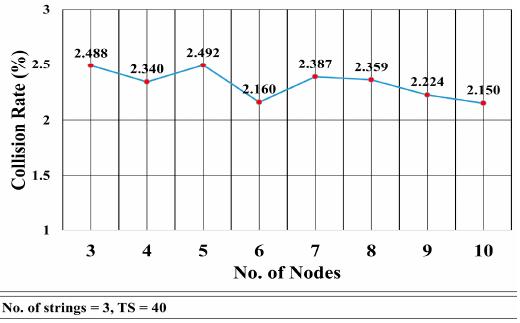
Figure 17. Collision Rate vs. Number of Nodes.